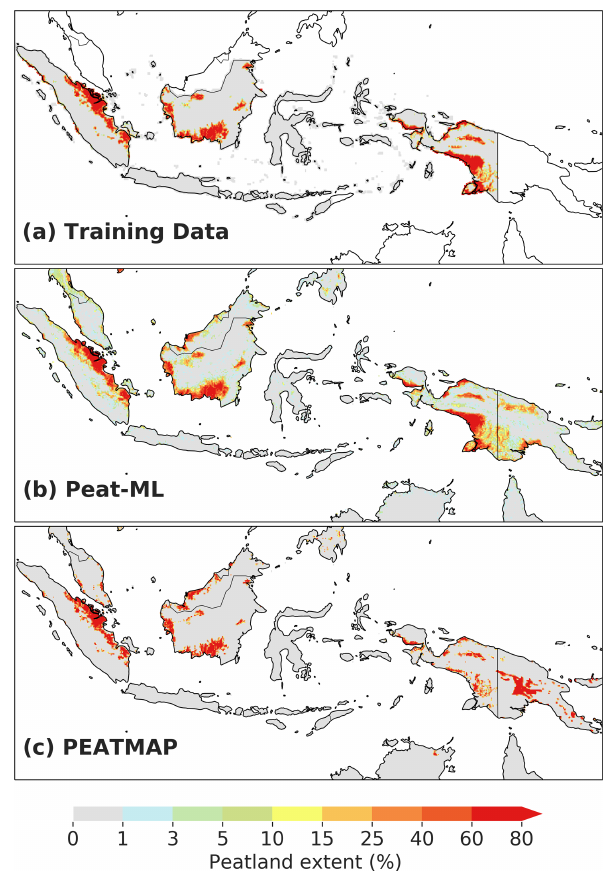
Figure A7. Peatland extent over the Indonesian archipelago. Panel (a) shows the ML training data, panel (b) shows the Peat-ML-predicted peatland extent, and panel (c) shows the PEATMAP extent from Xu et al. (2018).